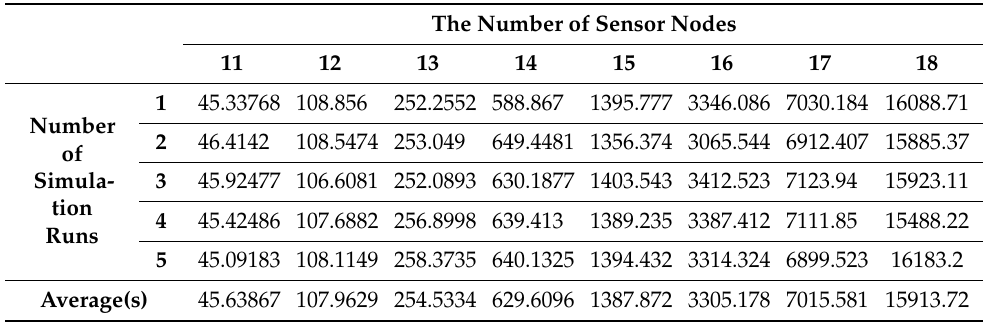
Table 1. Average spending time to check all cases.